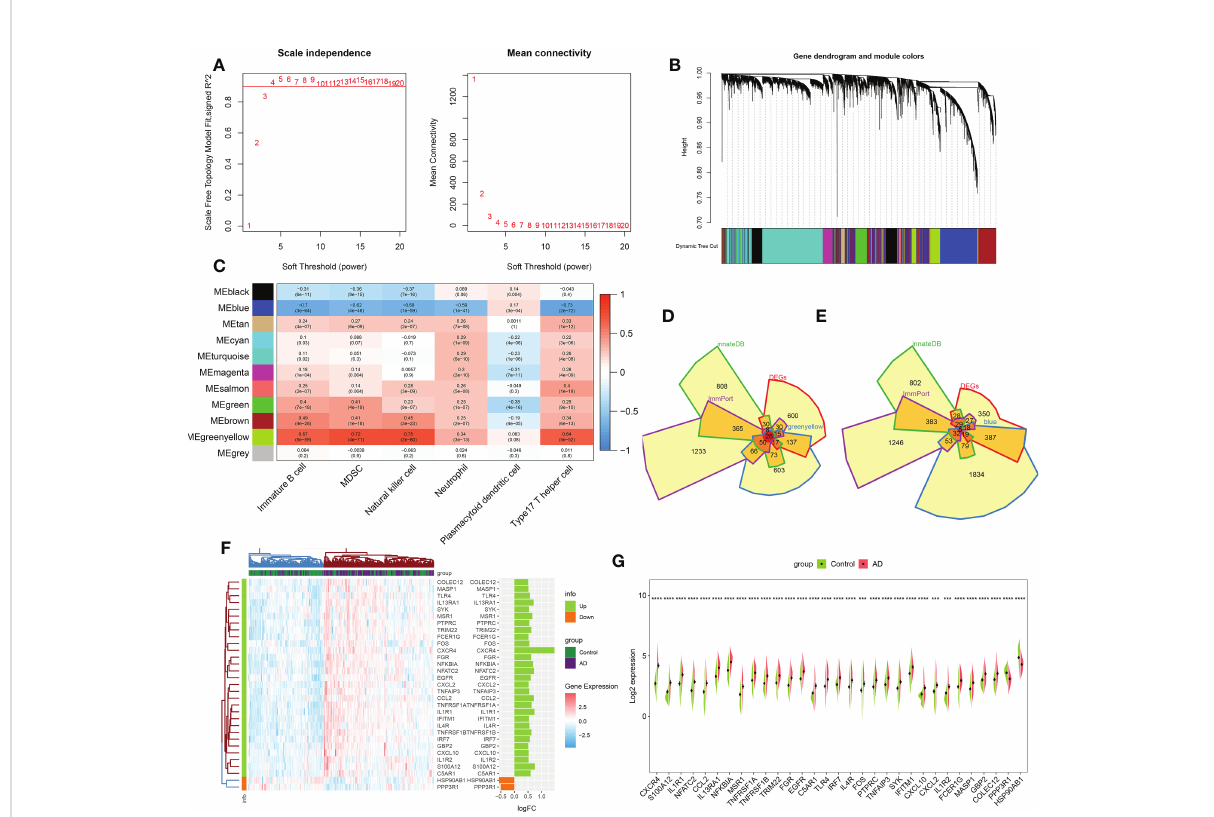
FIGURE 3 Identi fi cation of immune microenvironment-related DEGs between AD and controls. (A) The selection of soft threshold b . (B) Dendrogram of the co-expression module clustering tree. Distinct colors corresponded to the different co-expression modules. (C) Heatmap indicating the correlation between 11 modules with six types of immune cell. (D) Venn diagram showing the immune microenvironment-related DEGs shared by greenyellow module (986 genes), DEGs of AD (863 genes), immune genes from ImmPort (2483 genes) and innateDB (1879 genes) databases. (E) Venn diagram indicating the immune microenvironment-related DEGs shared by blue module (2426 genes), DEGs of AD (863 genes), immune genes from ImmPort (2483 genes) and innateDB (1879 genes) databases. (F, G) Heatmap (F) and split violin plots (G) revealing the expression of 31 immune microenvironment-related DEGs between AD and healthy controls. ***p < 0.001, ****p <